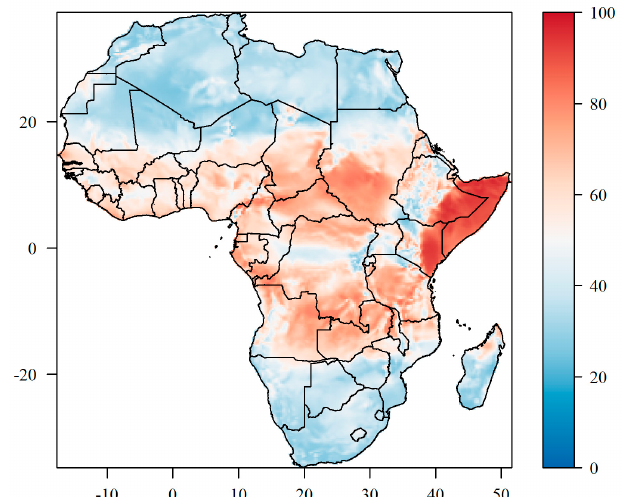
Figure 5. Percentage of the daily variability of CF at the annual scale that can be explained by the annual cycle of CF. The calculation of the statistic is inspired by the work of [9]. The percentage is expressed as α = σ 1 / σ 0 , where σ 0 is the standard deviation of daily CF values calculated from all daily data in the 2000–2017 period ( σ 02 = 1/(n − 1) Σ j = 1..n (CF(j) − μ ) 2 , where CF(j) is the daily CF value at day j, μ is the mean daily CF for the period and n is the number of days in the period), σ 1 is the standard deviation of daily CF values calculated from the 365 daily values of an average year ( σ 12 = 1/(365 − 1) Σ d = 1..365 (CF(d) − μ ) 2 where CF(d) is the inter-annual mean CF (mean over 18 years)) for the calendar day d = 1, 365 (i.e., value for d on the solid curve in Figure 1).